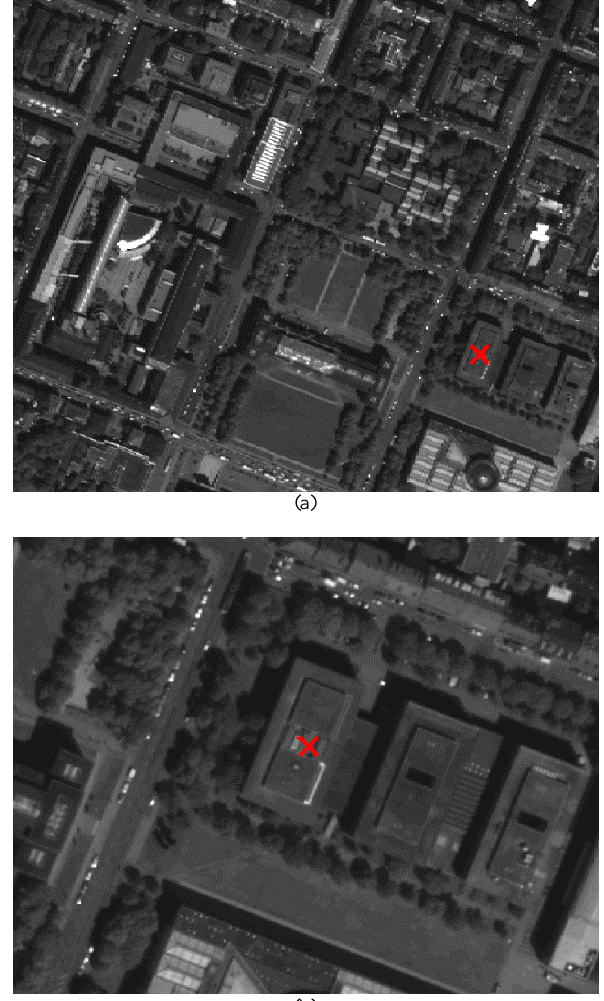
(b) Figure 2. Panchromatic Worldview-2 image with a mean pixel spacing of 49cm. (a) Overview. (b) Detail view. The red line indicates the projection history of the PTPs. The red cross shows the finally determined tie